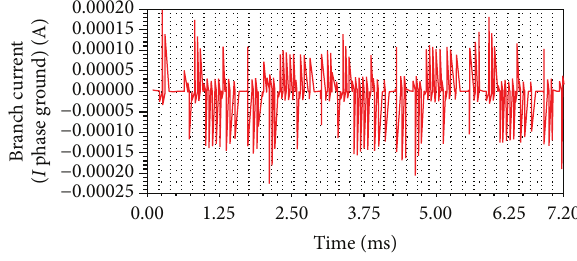
Figure 29: The leakage current in hysteresis control mode (with filter).